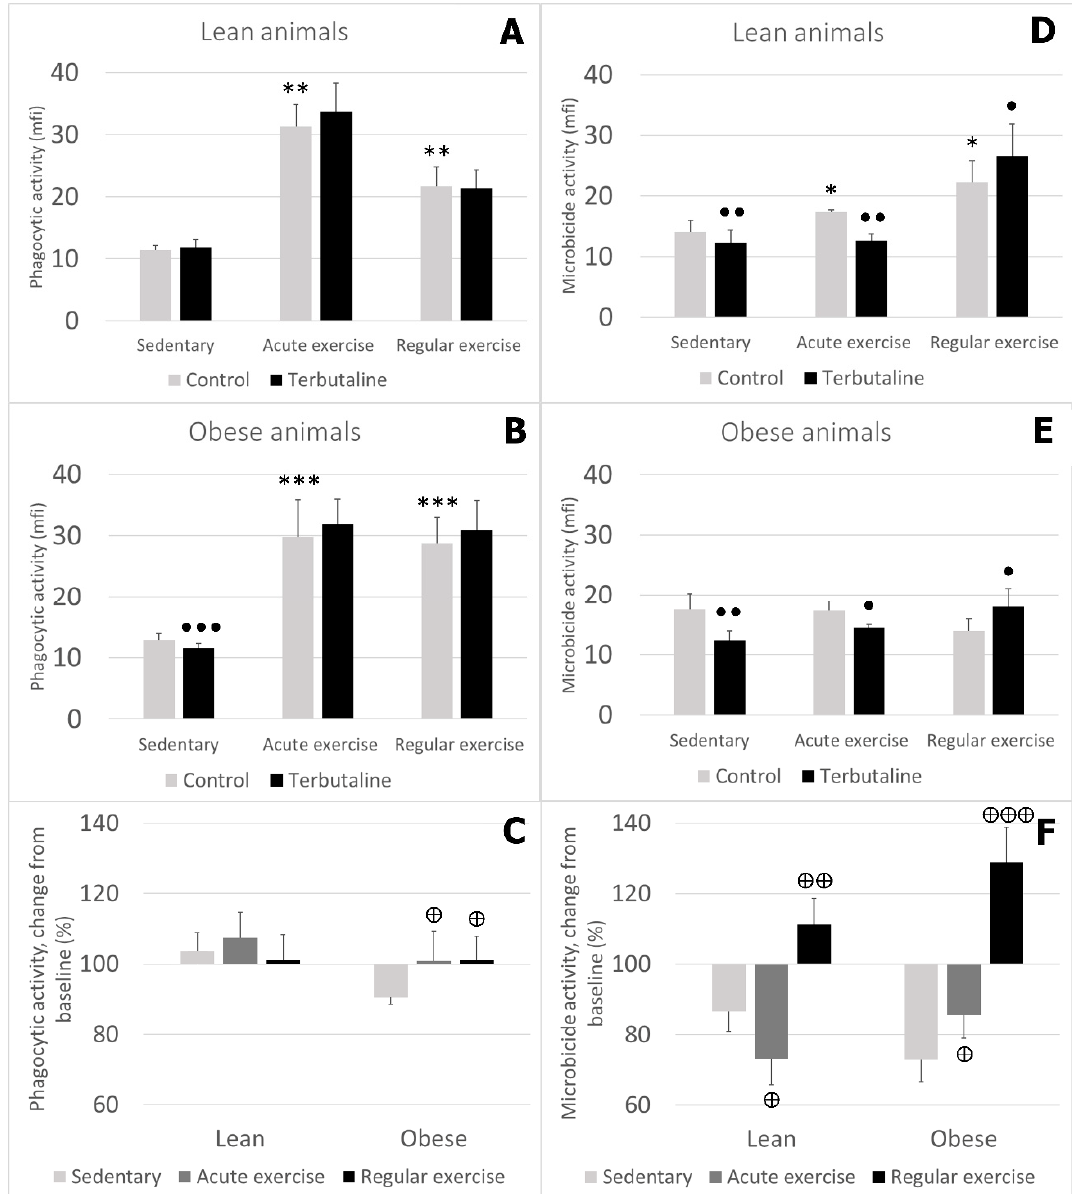
Figure 3. Effect of β 2 adrenergic agonist terbutaline on ( A–C ) phagocytic and ( D–F ) microbicide activity of circulating monocytes from ( A, D ) lean and ( B, E ) obese mice (sedentary, and acute and regular exercise); effect of terbutaline expressed as percentage change from ( C, F ) baseline, giving “100” to control values in terbutaline absence. Columns represent mean ± SEM of independent assays performed in duplicate. * p < 0.05, ** p < 0.01, and *** p < 0.001 vs. corresponding control sedentary value; • p < 0.05, ●● p < 0.01, and ●●● p < 0.001 vs. corresponding control value; ⊕ p < 0.05, ⊕⊕ p < 0.01, ⊕⊕⊕ p < 0.001 vs. corresponding sedentary value.